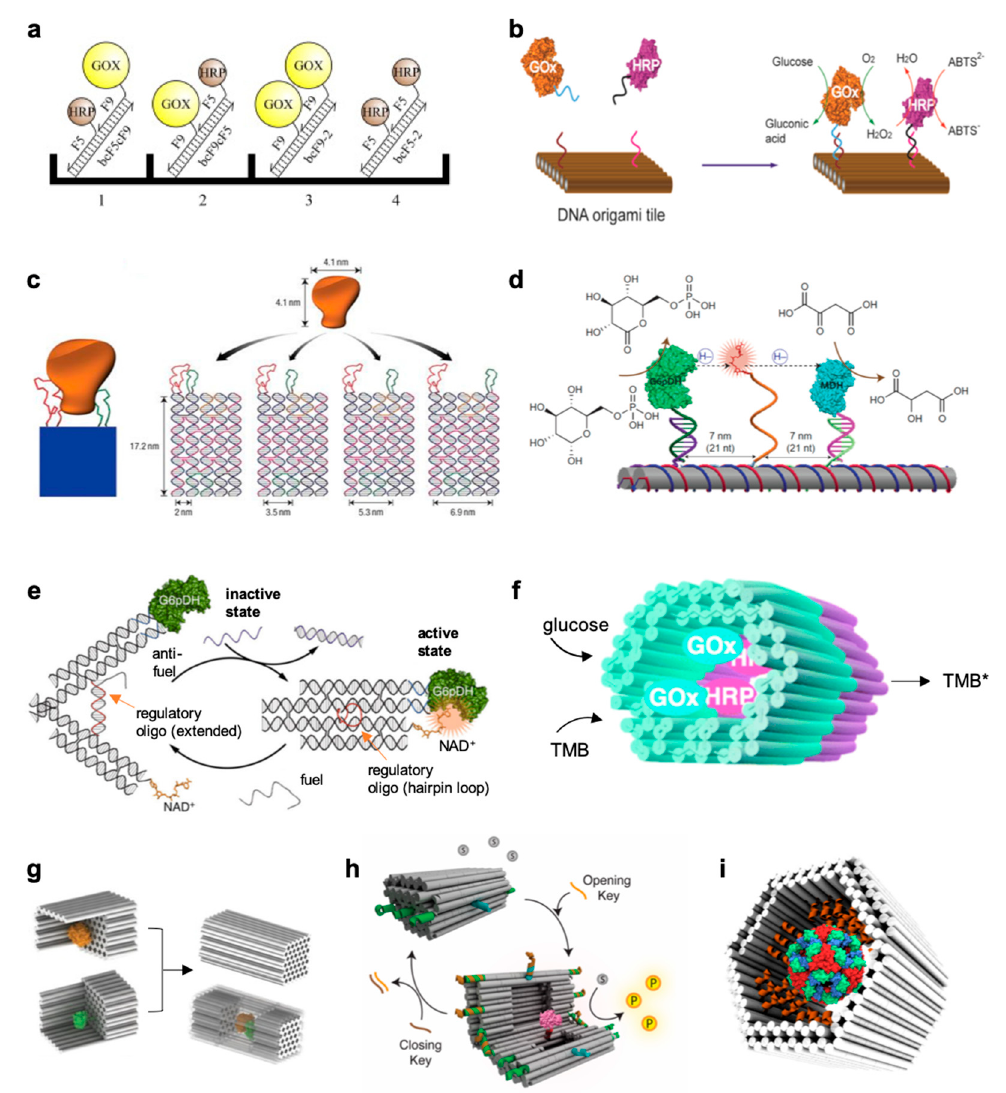
Figure 4. DNA-scaffolded enzymes in different geometric configurations. ( a ) Four different complexes were assembled by DNA-directed immobilization on a microplate surface, with different arrangements of GOx and HRP in homologous and heterologous pairs [66]. ( b ) Coassembly of GOx and HRP enzymes on a two-dimensional DNA origami structure with control over inter-enzyme distances [71]. ( c ) Schematic showing a rigid DNA tile (blue) that can spatially separate two ligands (red and green) at a controlled distance, with each ligand attached to a different part of the target molecule (orange) for bivalent binding [72]. ( d ) Schematic of the nanostructured complex consisting of glucose-6-phosphate dehydrogenase (G6pDH) and a malic dehydrogenase (MDH) organized on a DNA DX tile [73]. The NAD-modified single-stranded poly(T)20 is positioned halfway between the two enzymes, facilitating the transfer of hydrides. ( e ) Schematic illustration of a DNA tweezer-regulated enzyme nanoreactor [74]: a regulatory oligomer (shown in red) is designed to adopt a hairpin structure that holds the two arms of the tweezers close together, thus bringing the dehydrogenase enzyme (G6pDH) and its cofactor (NAD + ) in close proximity (active state). The addition of a fuel strand—complementary to the regulatory loop—results in the formation of a DNA double helix between the tweezer arms that separate the enzyme/cofactor pair (inactive state). ( f ) Two separately fabricated origami units are equipped with biotinylated glucose oxidase (GOx, cyan) and horseradish peroxidase (HRP, purple), respectively, through biotin–avidin interaction [75]. The units are linked together via base-pairing, resulting in a nanoreactor that is able to perform an enzyme cascade reaction. 3,3 ′ ,5,5 ′ -tetramethylbenzidine (TMB) is oxidized into TMB diimine (TMB*) in the presence of glucose and oxygen. ( g ) Schematic representations of the assembly of a DNA nanocage